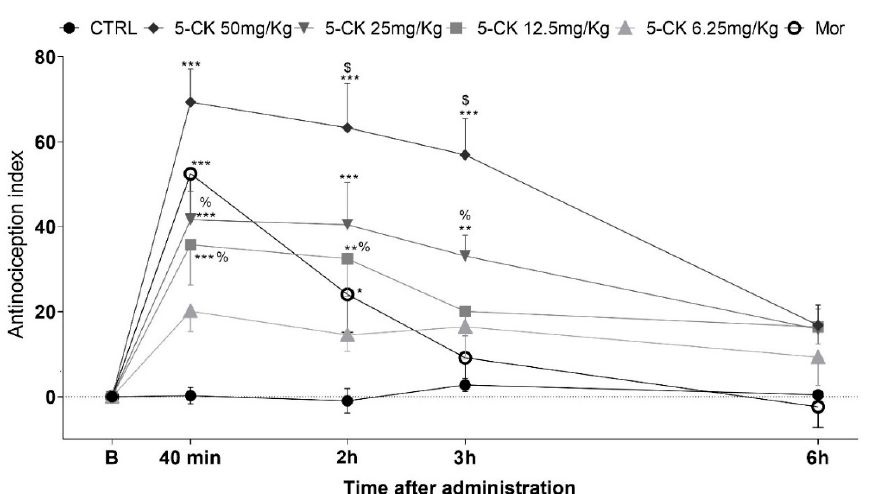
Figure 1. Effects of the systemic treatment with 5-CK in the early and late phases of the formalin test. Mice were treated with 5-CK (50-0.78 mg/Kg) or vehicle (CTRL, 50% propylene glycol in saline; control group) by intraperitoneal (ip.) route 40 min before formalin (injected at time zero). Morphine (Mor; 5 mg/Kg, ip.) and indomethacin (Indo; 10 mg/Kg, ip.) were used as reference drugs. Data are expressed as means ± SEM; n = 6 mice per group. * Significantly different from the control group ( p < 0.05). ** Significantly different from the control group ( p < 0.01). *** Significantly different from the control group ( p < 0.001) as determined by ANOVA followed by Tukey’s test.